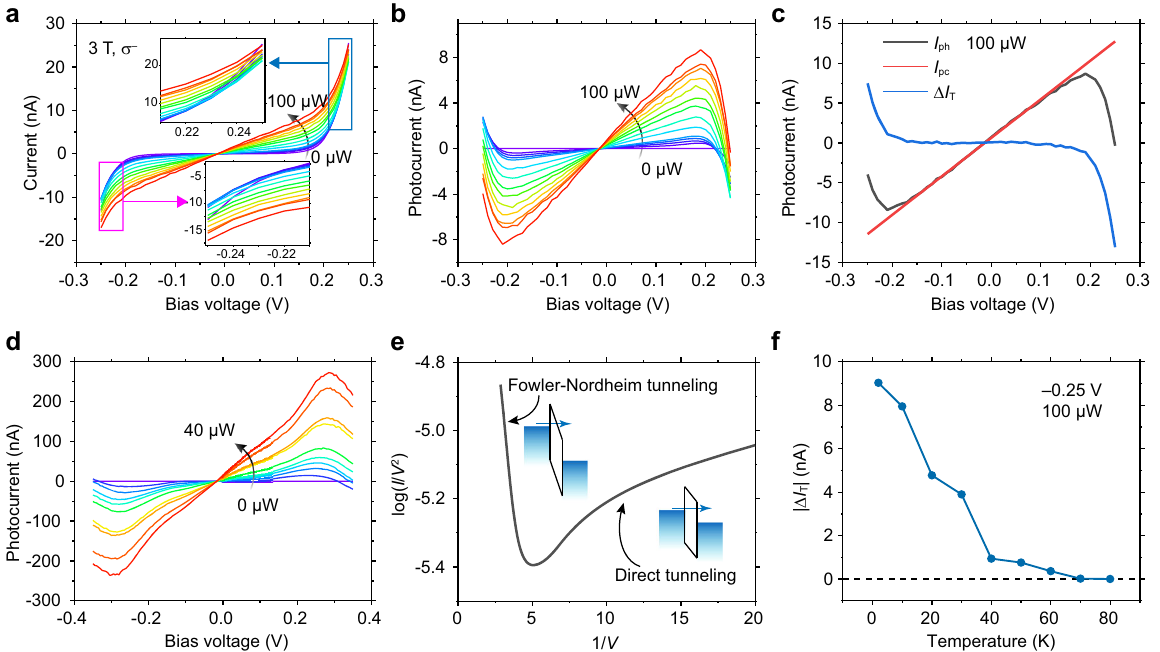
Fig. 5 The abnormal negative photocurrent in the CrI 3 devices. a I – V curves of the ~10 nm thick CrI 3 light helicity detector D3 under σ (cid:2) excitation with various powers (from 0 to 100 μ W) at μ 0 H = 3 T. The insets: the zoomed-in regions at higher bias. The I light – V curves are linear within V = ±0.19 V, but become nonlinear and cross to each other at higher bias. b The photocurrents I ph obtained from ( a ) by subtracting I dark from I light . For all the excitation powers, the I ph increases linearly with bias within ±0.19 V, but deviates from linear behavior and even decreases at higher bias, resulting in a negative photocurrent. c The I ph – V curve under 100 μ W excitation (black line), the I pc – V curve extracted by linear fi tting the I ph – V curve within V = ±0.15 V, and extending the result to the full bias range of ±0.25 V (red line), and the Δ I T – V curve (blue line) obtained by subtracting I pc from I ph . Under light illumination, the tunneling current decreases for bias voltages | V | > 0.19 V. d The I ph – V curves in the monolayer CrI 3 device D1 under various excitation powers at μ H = 0 T. The negative photocurrent phenomenon occurs at bias higher than 0.25 V. e The dark tunneling currents in the monolayer CrI 0 plotted in the log( I / V 2 ) – 1/ V diagram. The negative (positive) slope of the curve at high (low) bias region indicates the Fowler – Nordheim tunneling (direct tunneling) mechanism. The two insets: the energy band diagrams of the two tunneling mechanism, the left for the Fowler – Nordheim tunneling and the right for the direct tunneling. f The temperature-dependent | Δ I T | in D3 measured at V = − 0.25 V under 100 μ W light excitation. With the temperature increasing, | Δ I T | decreases monotonously until zero (the dashed line) at a temperature higher than 60